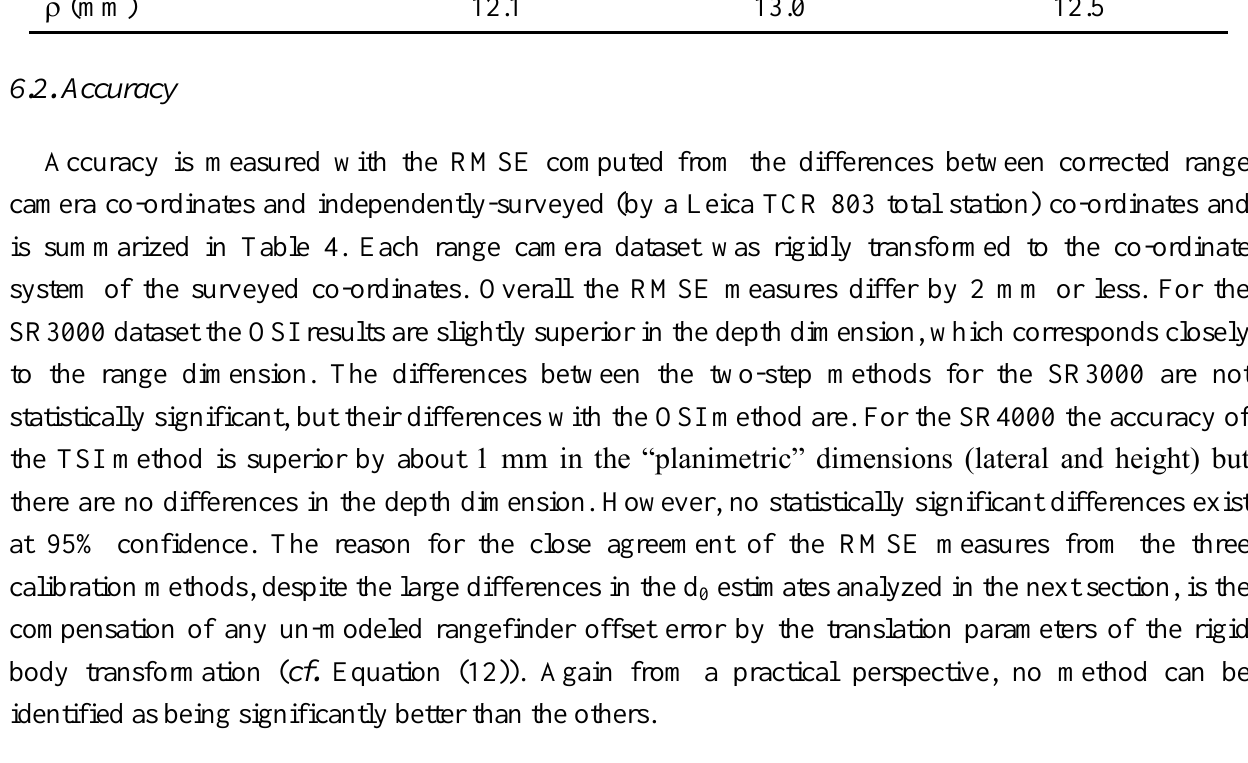
Table 4. Accuracy assessment statistical